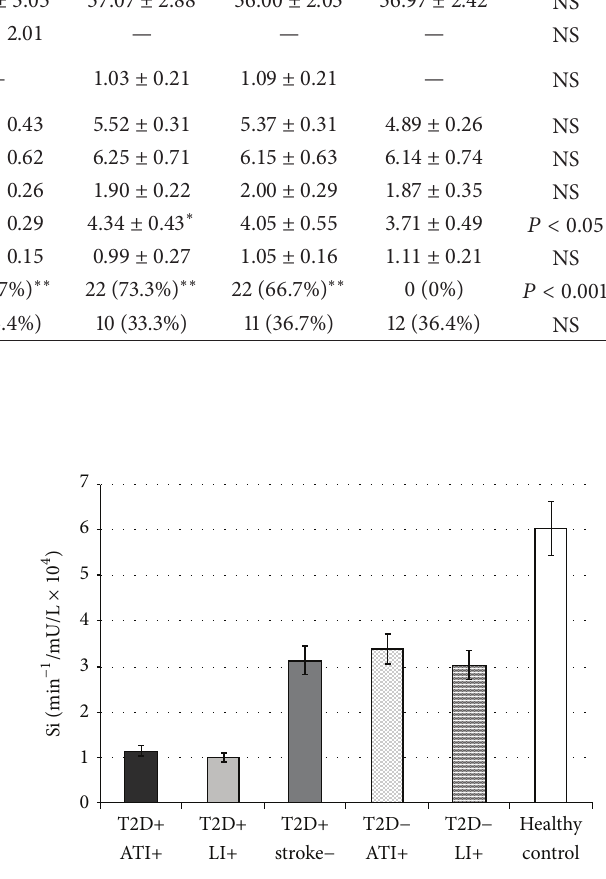
Figure 1: Values are expressed as mean ± SE. Bar graphs show the values of insulin sensitivity index (Si) determined by minimal model analysis. Si levels were significantly lower in type 2 diabetic (T2D) patients with different subtypes of ischemic stroke: atherothrom- botic infarction (ATI) and lacunar infarction (LI) compared to T2D patients without ischemic stroke, and the same relationship is found in the respective groups in nondiabetics ( 𝑃 < 0.001 ) (ANOVA